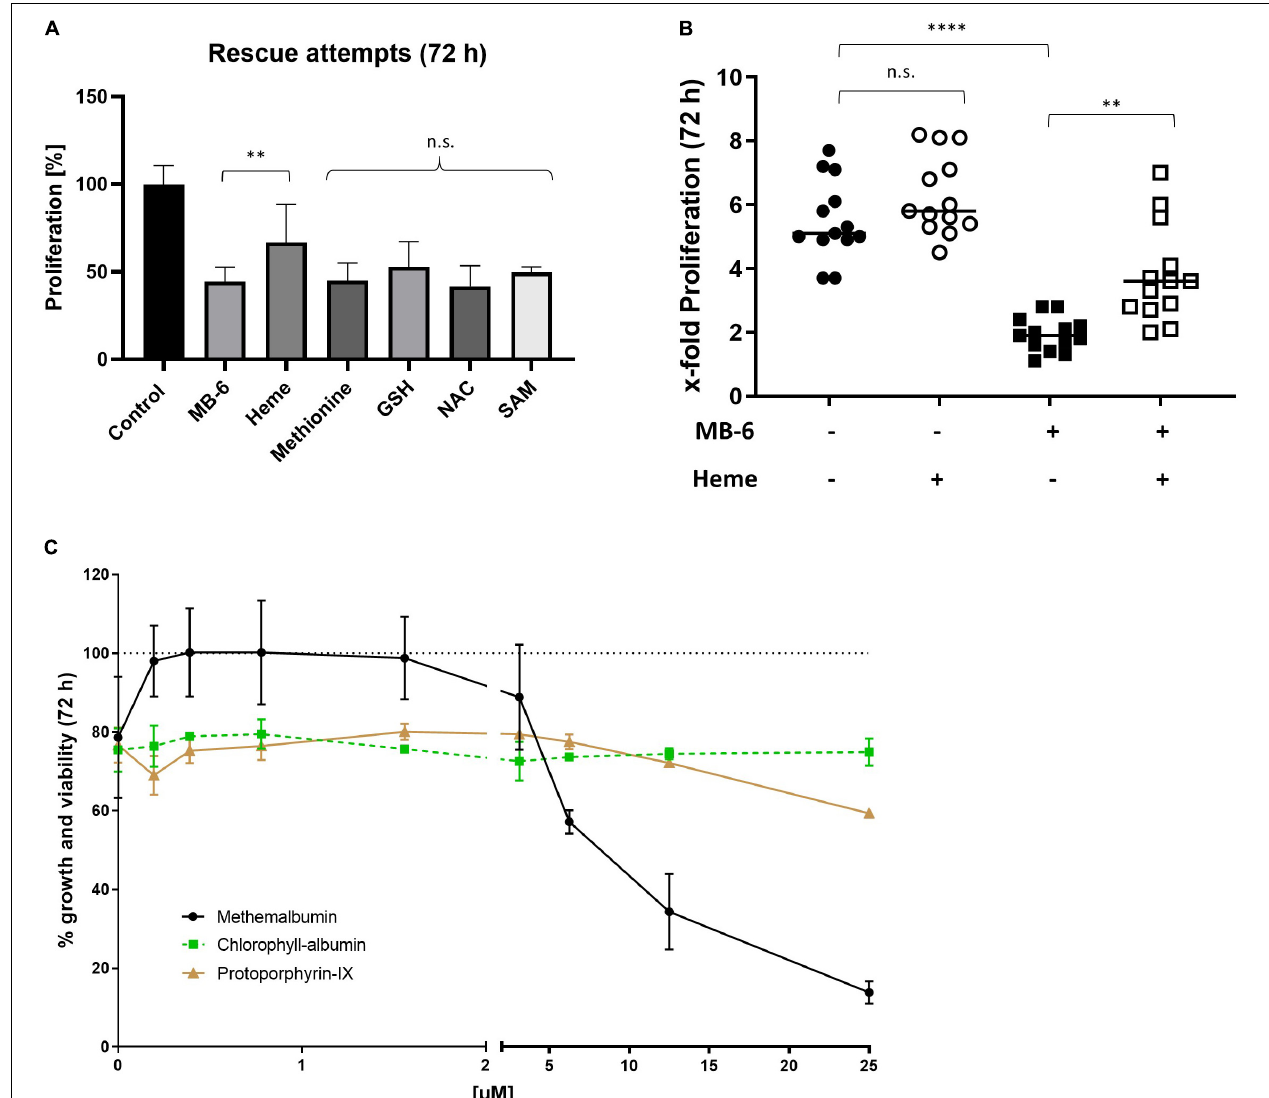
FIGURE 6 | Proliferation inhibition by MB-6 can be partially rescued by methemalbumin supplementation but not by closely related heme analogs. (A) Proliferation is rescued by providing cells with heme in the form of methemalbumin but not by providing various means of restoring the impaired GSH/GSSG status. (B) Methemalbumin addition partially rescues cellular proliferation of MB-6 treated cells but does not affect cellular proliferation on its own. (C) The described rescue effect is specific to methemalbumin. Neither protoporphyrin-IX-albumin (lacking the iron), nor chlorophyll-albumin (containing redox-active Mg instead of iron), improve the impairment in growth in viability caused by MB-6. Note that methemalbumin becomes toxic at higher concentrations. ** p < 0.01, **** p <